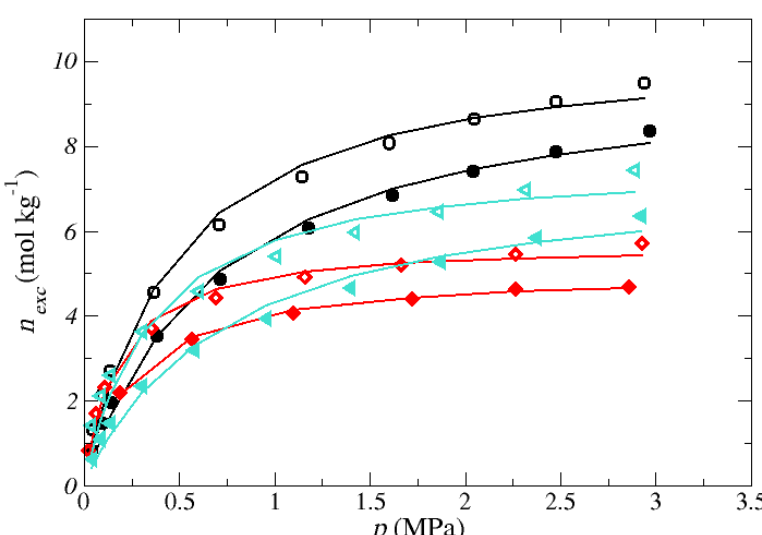
Figure 3. CO 2 adsorption isotherms for the three olive stone-based activated carbons: AC-H 3 PO 4 (black circles), AC-CO 2 (red diamonds) and AC-H 2 O (turquoise triangles). Open symbols represent the adsorption data at 303.15 K, while the data at 323.15 are shown by the filled symbols. Uncertainties: ∆ p = 0.01 MPa, ∆ T = 0.2 K. The obtained Langmuir fitting isotherms are shown by the solid lines.